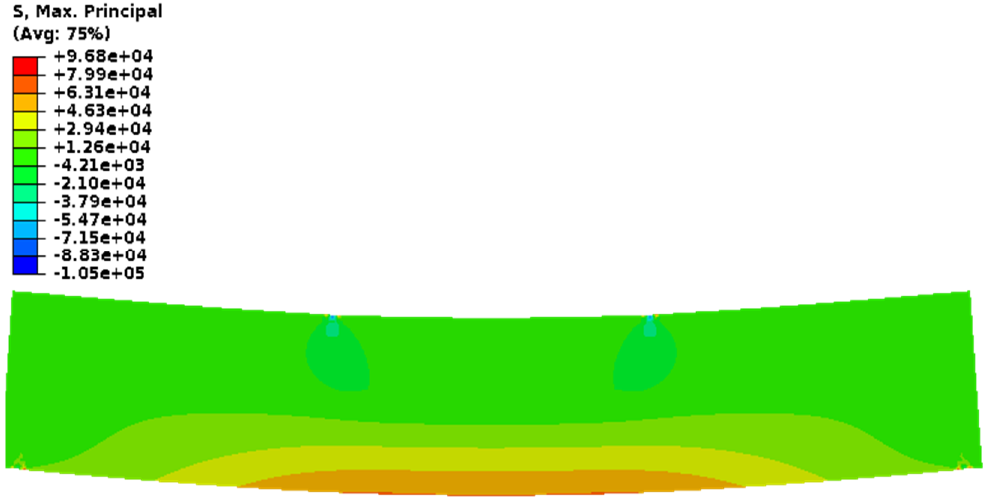
Figure 9. Maximum principal stresses for four-point bending of a simply supported concrete beam.